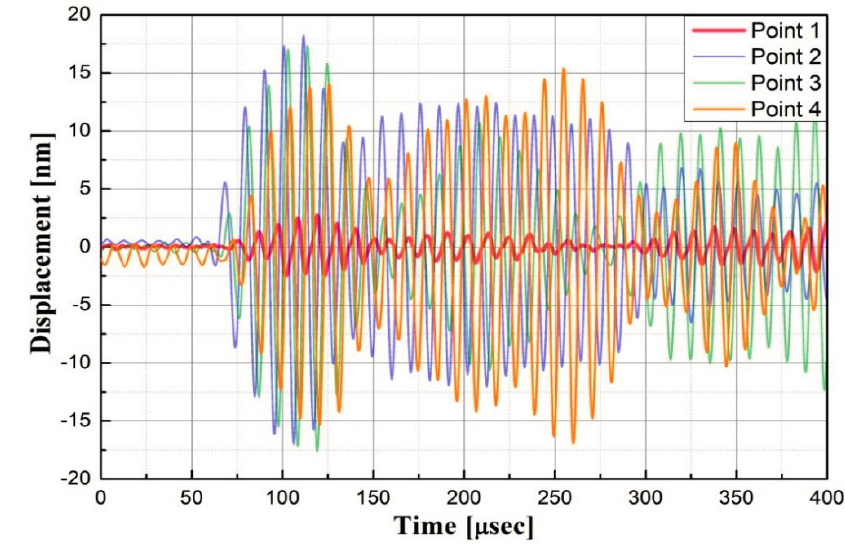
Figure 6. Waveforms collected at Points